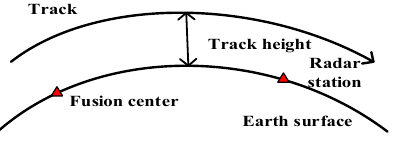
Figure 2. Schematic diagram of station site.